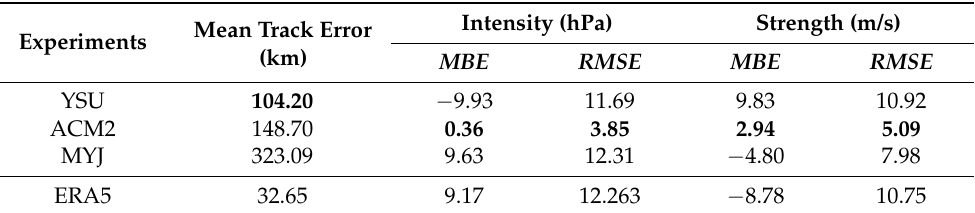
Table 2. Mean track error, MBE , and RMSE scores for intensity and strength with respect to three WRF experiments and ERA5. Boldface denotes best score among PBL schemes.